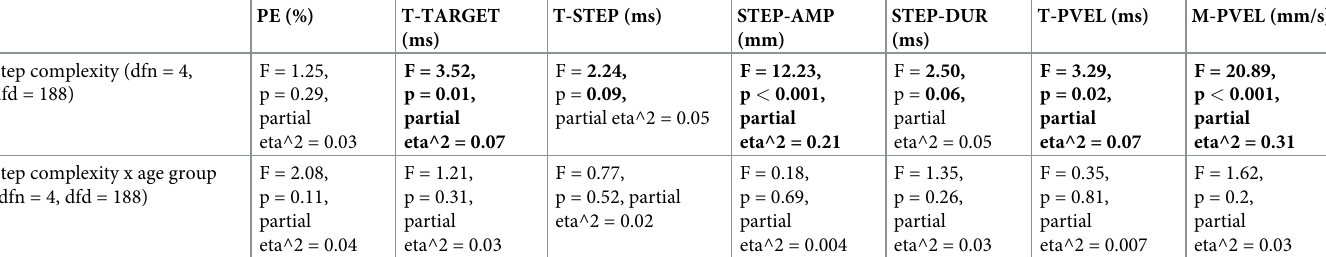
Table 6. Effect table for the effect of step complexity and age group on sequence learning effects.